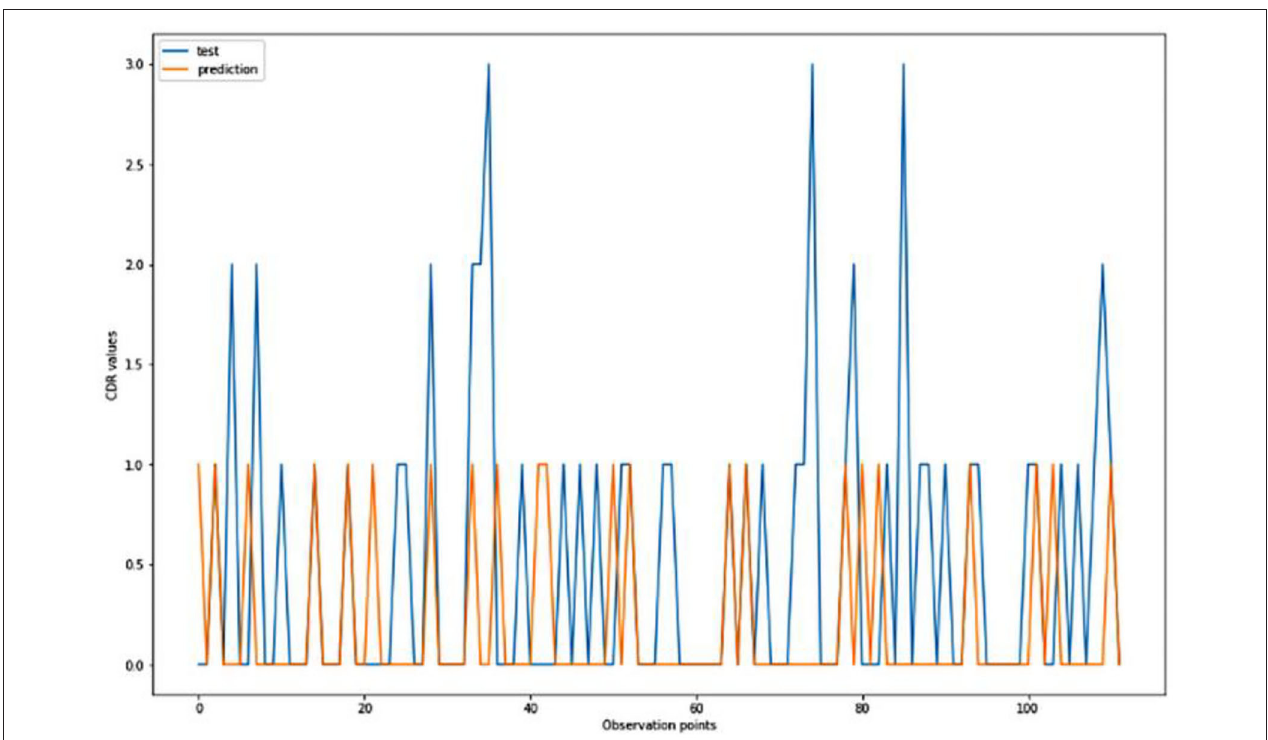
FIGURE 4 | Graphical representation of the comparison of test and predicted CDR values obtained using the logistic regression algorithm. (six parameters).